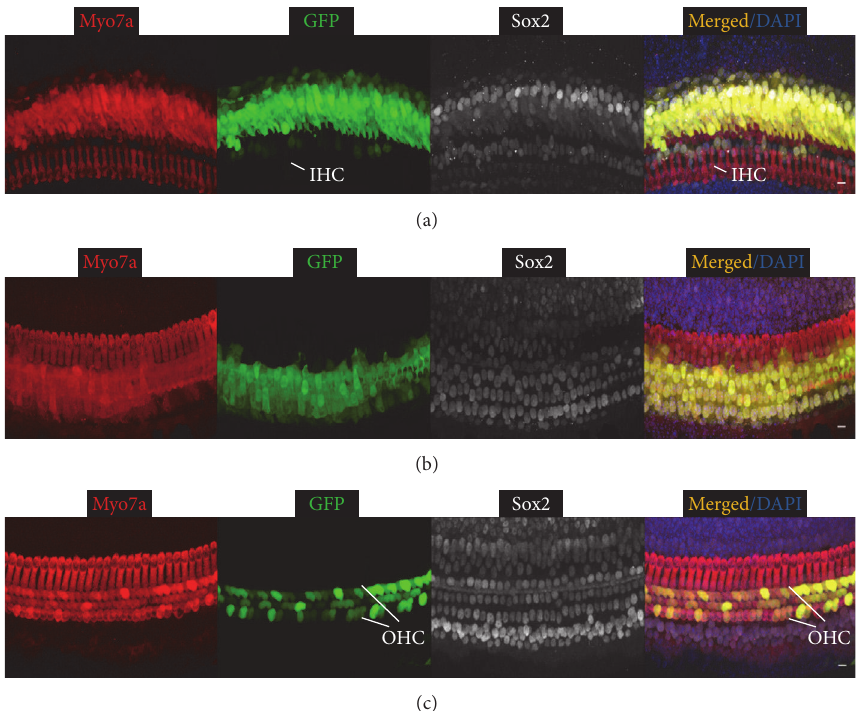
Figure 2: Ad-GFP-Baylor transduces diverse cochlear cell types when injected at P0. Representative confocal images of whole-mount fluorescent immunolabeling of cochlea injected at P0 to illustrate the basal (a), middle (b), and apical turns (c). Ad-GFP-Baylor transduces supporting cells (SCs) and inner hair cells (IHCs) at basal (a), SCs at middle (b), and outer hair cells (OHCs) at apical turns (c). IHC: inner hair cell, OHC: outer hair cell, and SC: supporting cell. Scale bars: 10 𝜇 m.